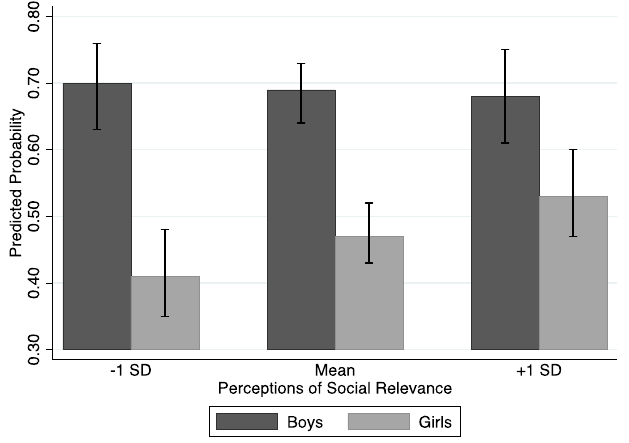
Figure 2. Predicted probability of expecting to major in STEM by perceptions of social relevance and gender.